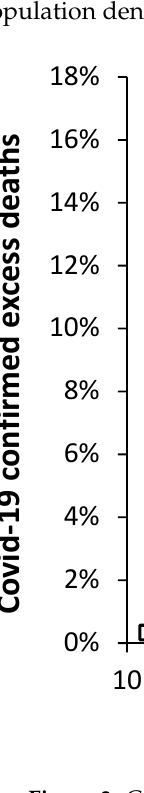
Figure 3. Covid-19 confirmed “excess” deaths (as at 9th June 2020) relative to 2018 as the base year versus county-level weighted state population density.